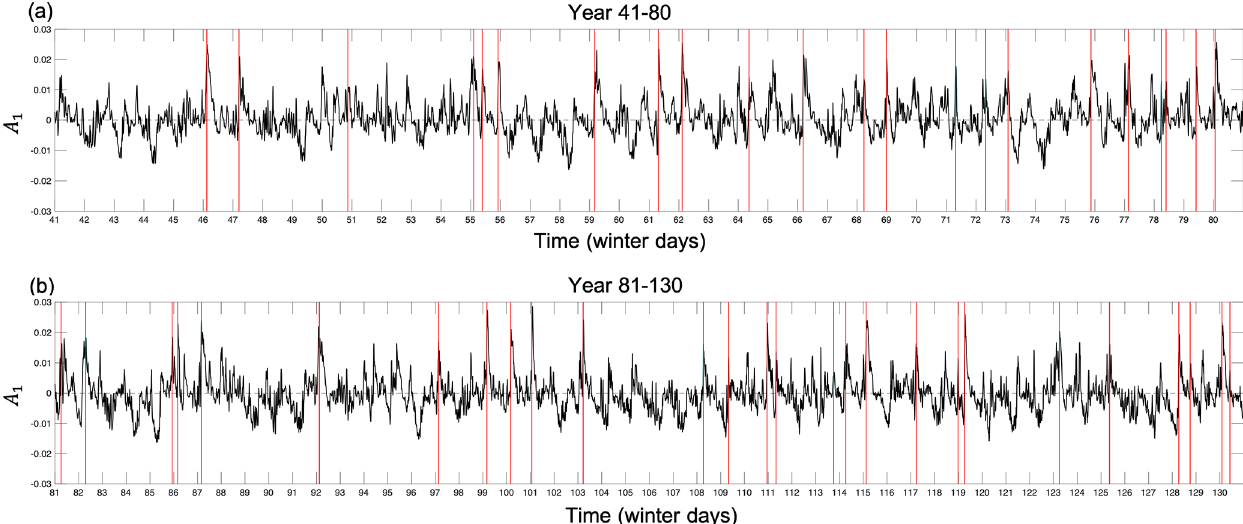
Figure C2. The PC time series ( A 1 ) of winter days corresponding to the first EOF spatial pattern ( E 1 ) using daily Isca model winter data (from October to April) for the (a) years 41–80 and (b) years 81–130. The PC time series for the winter days of the years 1–40 can be seen in Fig. 2b. The red lines indicate the onset dates of SSW